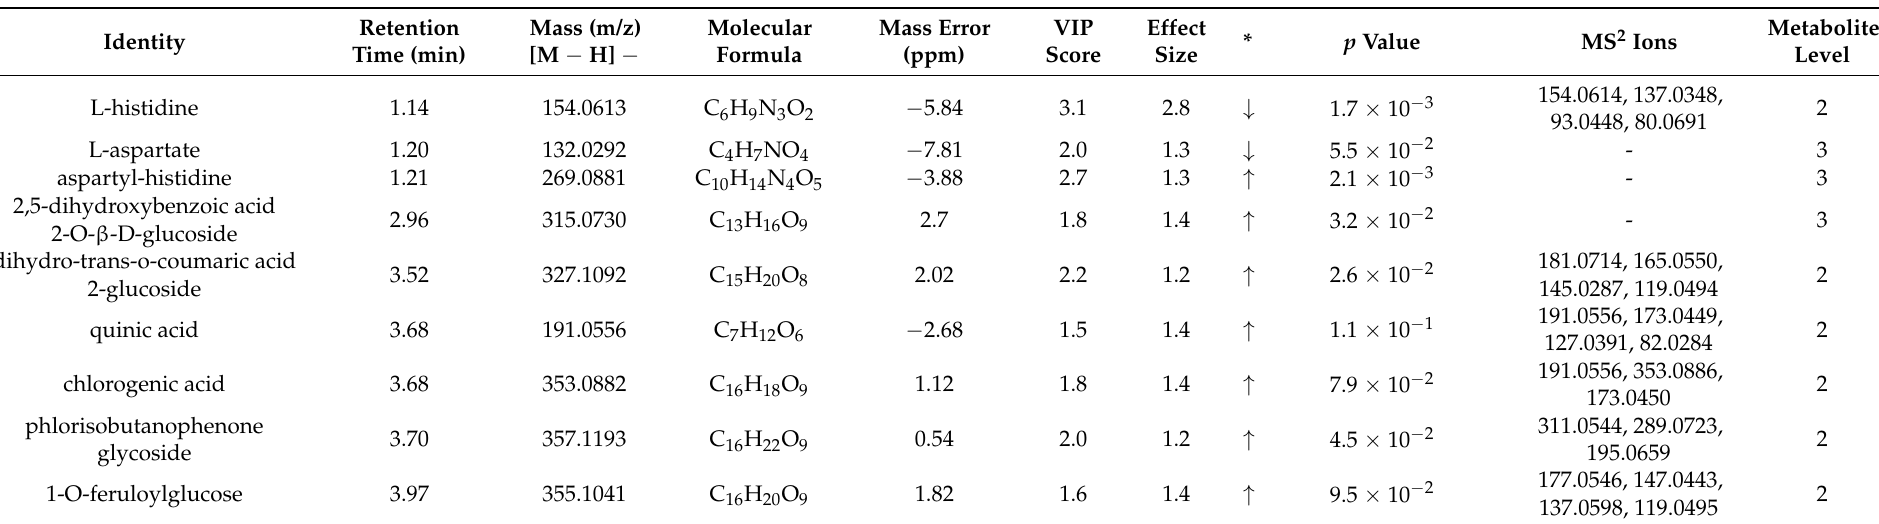
Table 4. Metabolites identified in UHPLC-HRMS ESI- data that were significant (VIP > 1.5) in the OPLSDA model between RV HIGH compared to RV LOW apple spur buds with associated effect size. p values indicate those metabolites that are significant in the linear model with the (y ~ returnbloom) for RV LOW , RV MID and RV HIGH